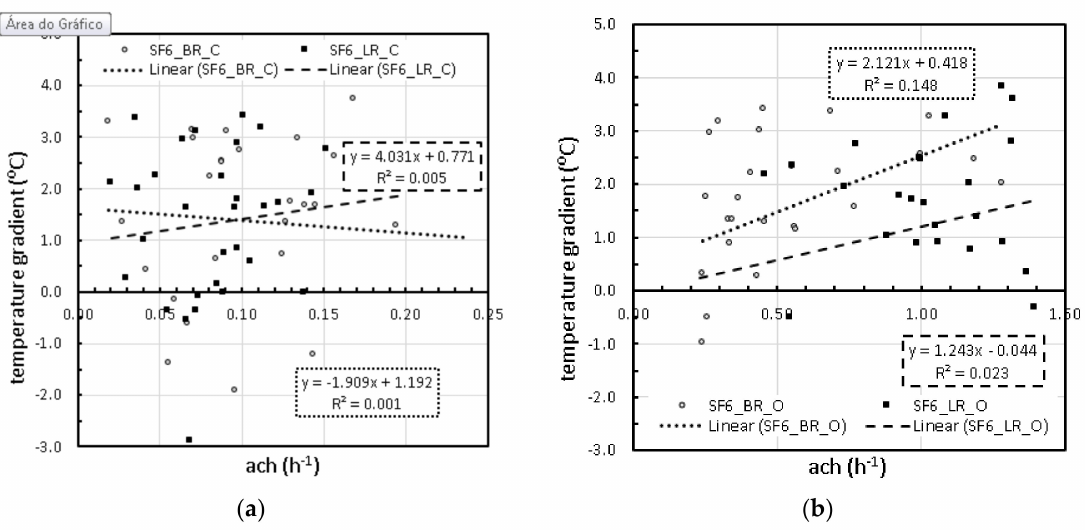
Figure 11. Air change rate versus indoor–outdoor temperature gradient: ( a ) Sulfur hexafluoride (SF 6 )—door closed; ( b ) Sulfur hexafluoride (SF 6 )—door